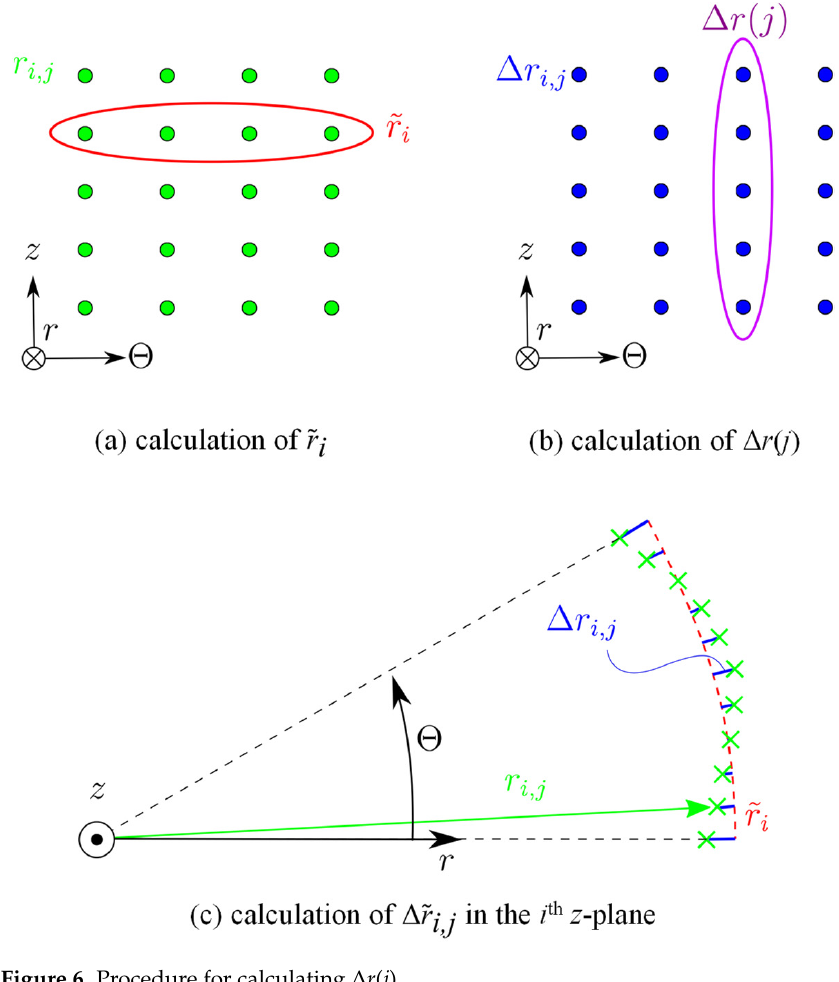
Figure 6. Procedure for calculating Δ r ( j ).